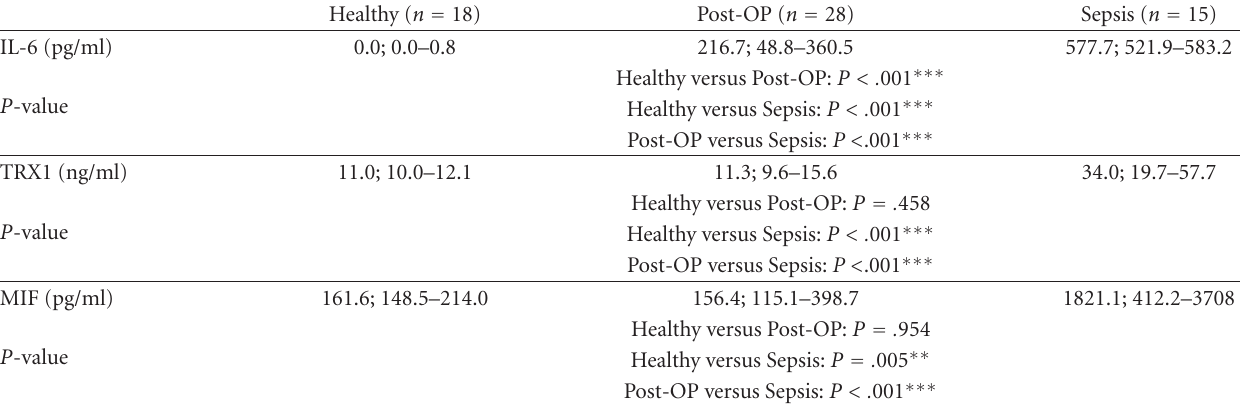
Table 3: Comparison of IL-6, TRX1, and MIF plasma levels in the volunteer, postoperative, and septic group at baseline.